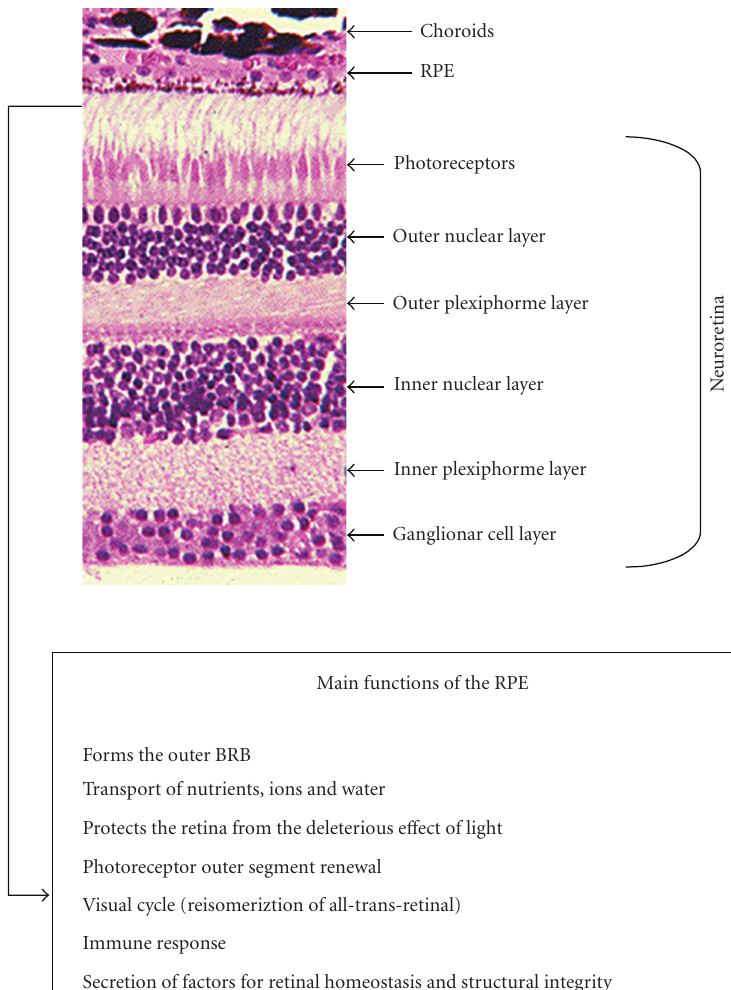
Figure 1: Retinal section of the retina showing the location of the retinal pigment epithelium (RPE). In the box are listed the main functions of